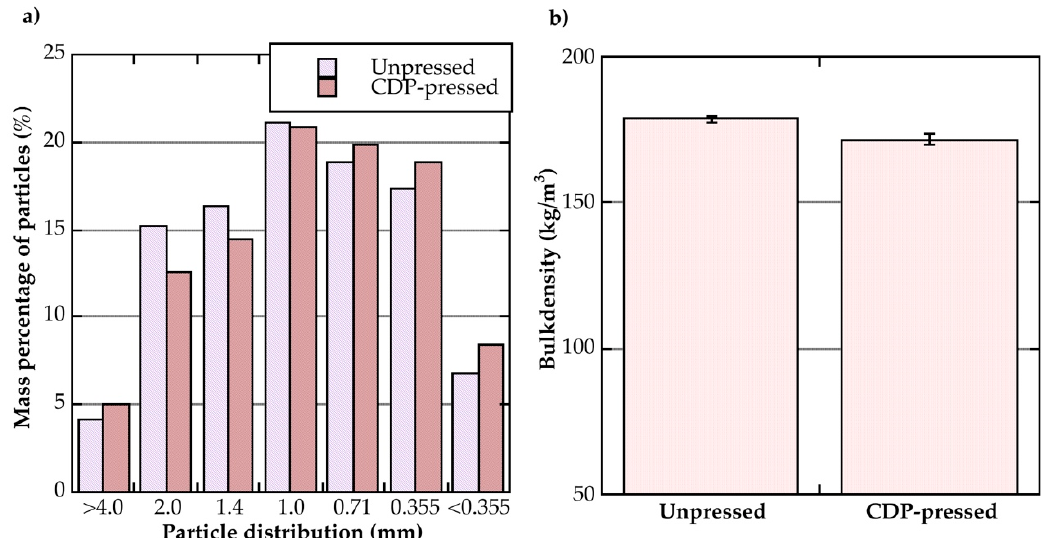
Figure6. E ff ectsonsawdustpropertiesforunpressedandCDP-pressedsawdust: ( a )Particledistribution Figure 6. Effects on sawdust properties for unpressed and CDP-pressed sawdust: ( a ) Particle distribution for sawdust sieved at a moisture content of 12% and divided into seven di ff erent sieves; ( b ) bulk density for sawdust sieved at a moisture content of 12% and divided into seven different sieves; ( b ) bulk density for unpressed and CDP-pressed sawdust tested at 6% moisture for unpressed and CDP-pressed sawdust tested at 6% moisture content.